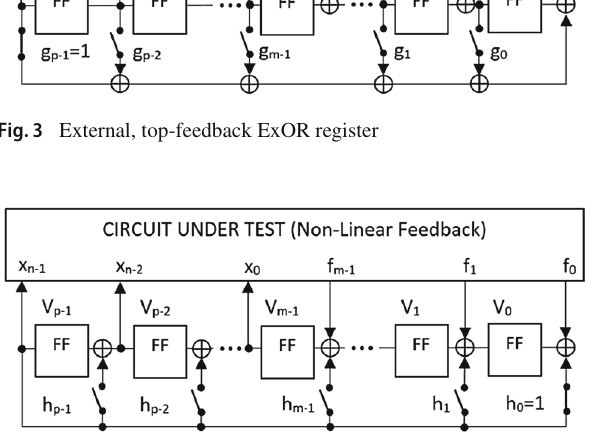
Fig. 4 Internal, bottom-feedback ExOR register